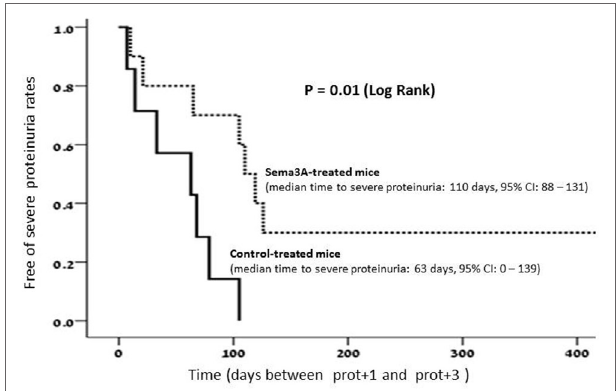
FigUre 1 | In semaphorin3A (sema3A)-treated mice, the median time to severe proteinuria was 110 days, 95% CI: 88–131. Whereas in control-treated mice, the median time to severe proteinuria was 63 days, 95%, CI: